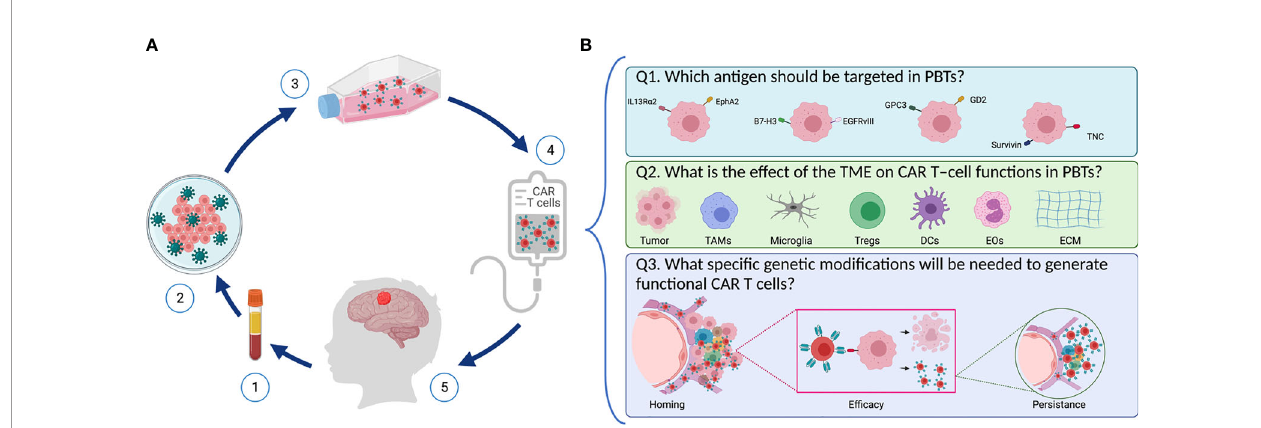
FIGURE 1 | Designing safe, effective, and long-lasting T-cell therapies for PBTs. (A) Scheme representing CAR T – cell treatment via adoptive T cell transfer in pediatric patients with brain tumors. (1) T cells are isolated from patient ’ s blood followed by (2) T cell activation and reprograming in the lab to express the chimeric antigen receptor (CAR) using viral vectors. (3) CAR T – cells are then expanded, and they undergo quality control testing (4) prior to infusion into the patient (5). (B) Key questions to address when designing CAR T – cells for PBTs. (1) Selecting an appropriate target: Several TAAs (including IL13R a 2, EphA2, B7-H3, GD2, EGFRvIII, and TNC) are expressed in PBTs with heterogenous expression patterns. (2) Overcoming the suppressive immune TME: Immune cells (like TAMs, DCs, Tregs, and EOs) in fi ltrate PBTs and they induce different immune interactions that affect the CAR T – cells ’ ability to perform their cytotoxic properties. (3) Once infused, CAR T – cells need to home to the patient ’ s tumor and exert their cytolytic activity while expanding and persisting to create long-lasting